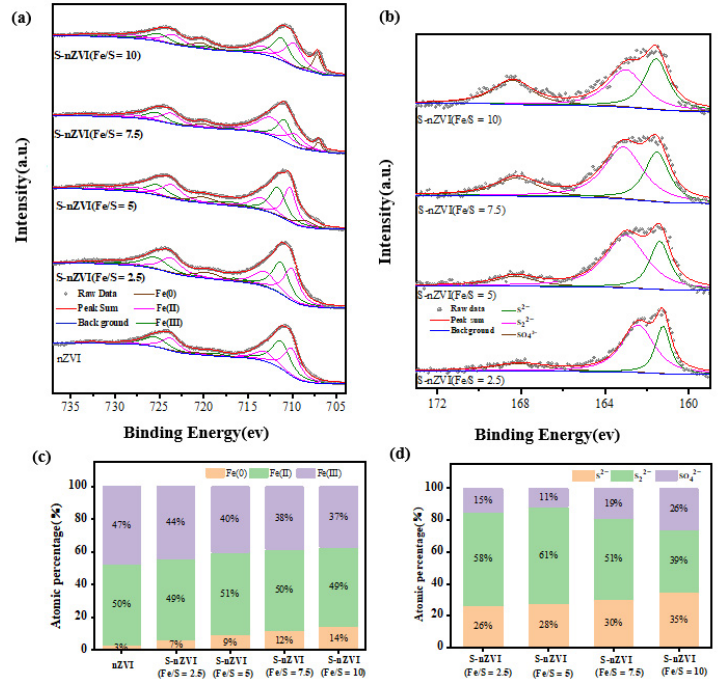
Figure 3. XPS spectra of nZVI and S-nZVI materials with different Fe/S ratios: ( a ) XPS spectrum of Fe2 p; ( b ) XPS spectrum of S 2p; ( c ) Fe levels in different valences; ( d ) S levels in different valences.